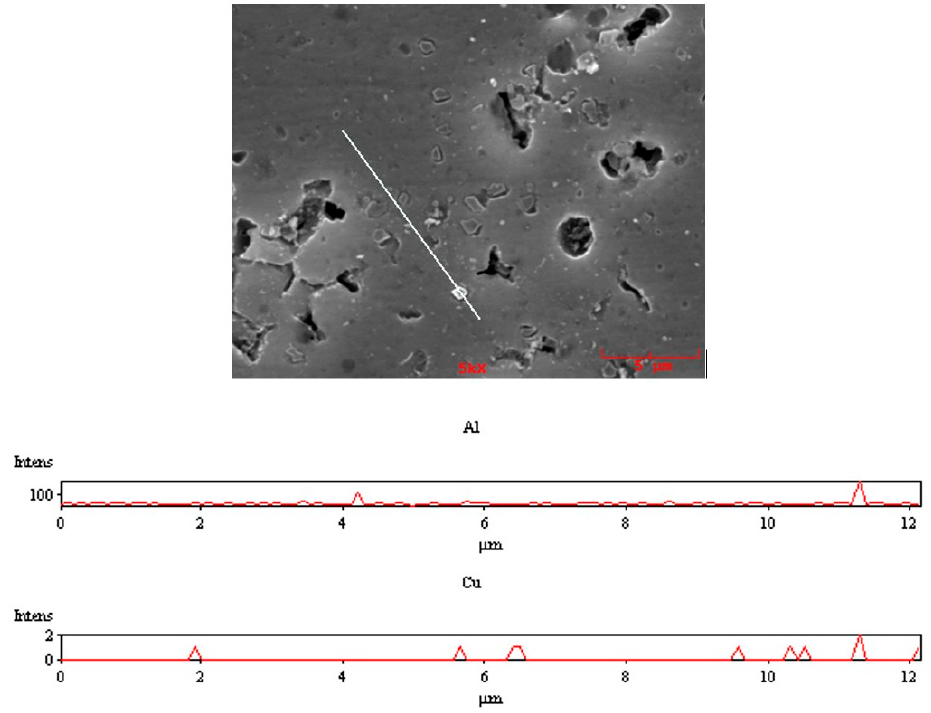
Figure 19. Energy dispersed spectrometer (EDS) linear analysis (630/50/1 specimen, zone No. 1).